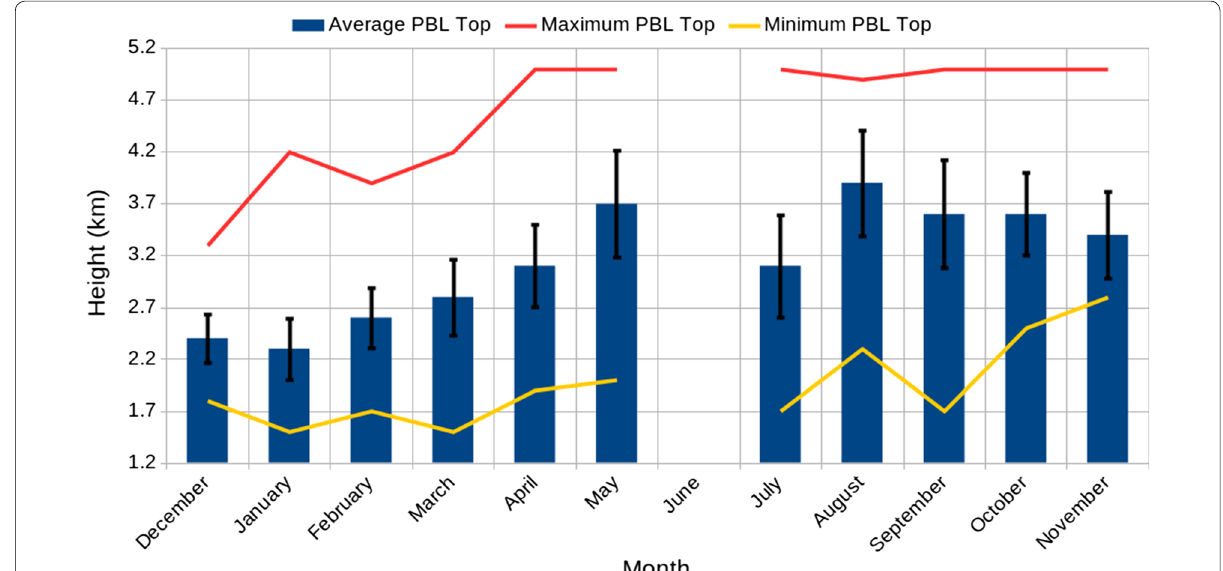
Fig. 5 PBL echo layer results. The heights of the tops of the PBL as a function of month, using our echo layers as a proxy for PBL. The average value of the PBL per month, as well as the maximum and minimum heights observed for individual days, is shown. The average PBL top is at the greatest heights during May and August. A local minimum is observed during July, while the yearly minimum value was registered during January. The variability is shown as black vertical line bars which represent half standard ±